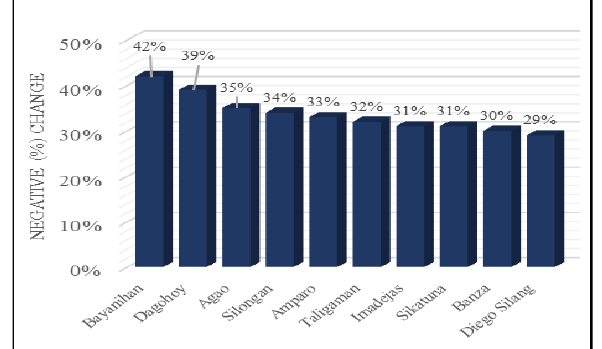
Figure 17. Top 10 barangays with decreasing carbon footprint in the lockdown period.